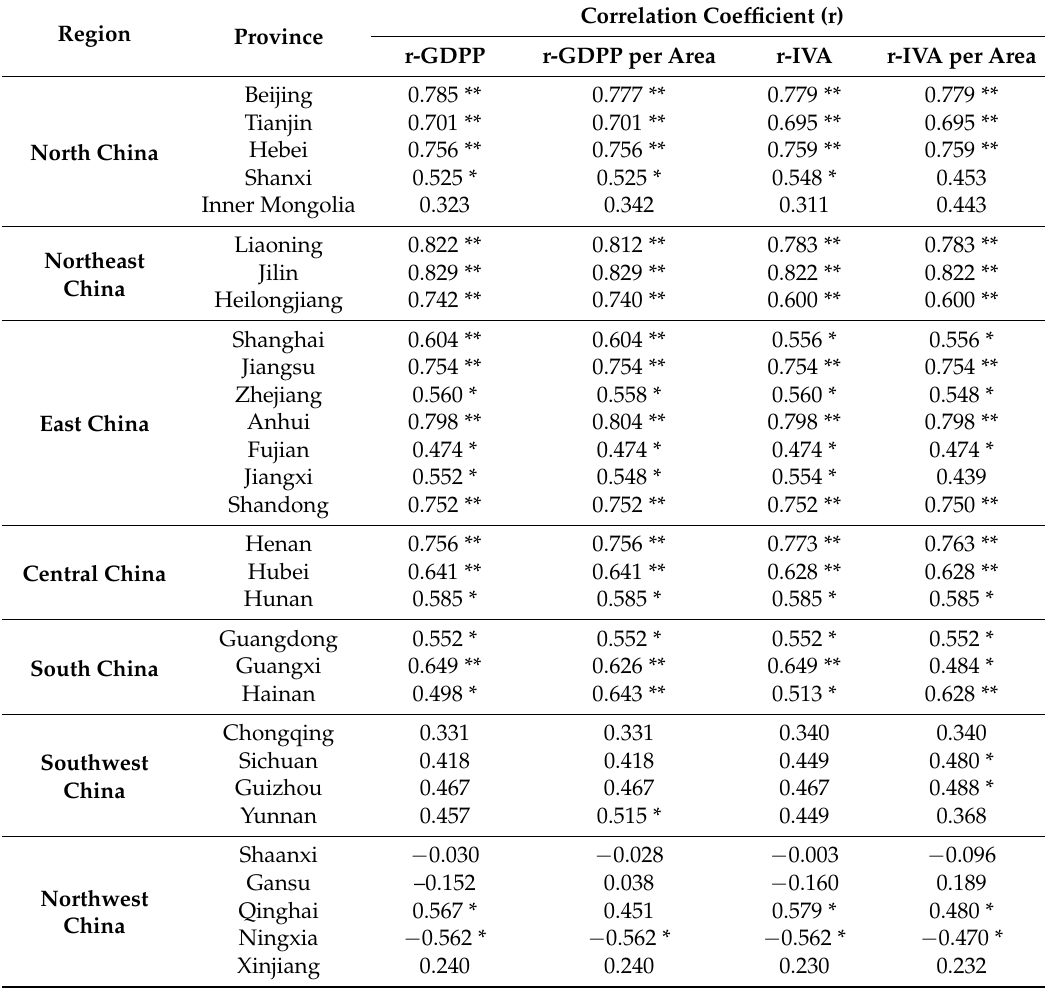
Table 5. The correlation coefficients of provinces in seven geographical subareas, 1998–2015.